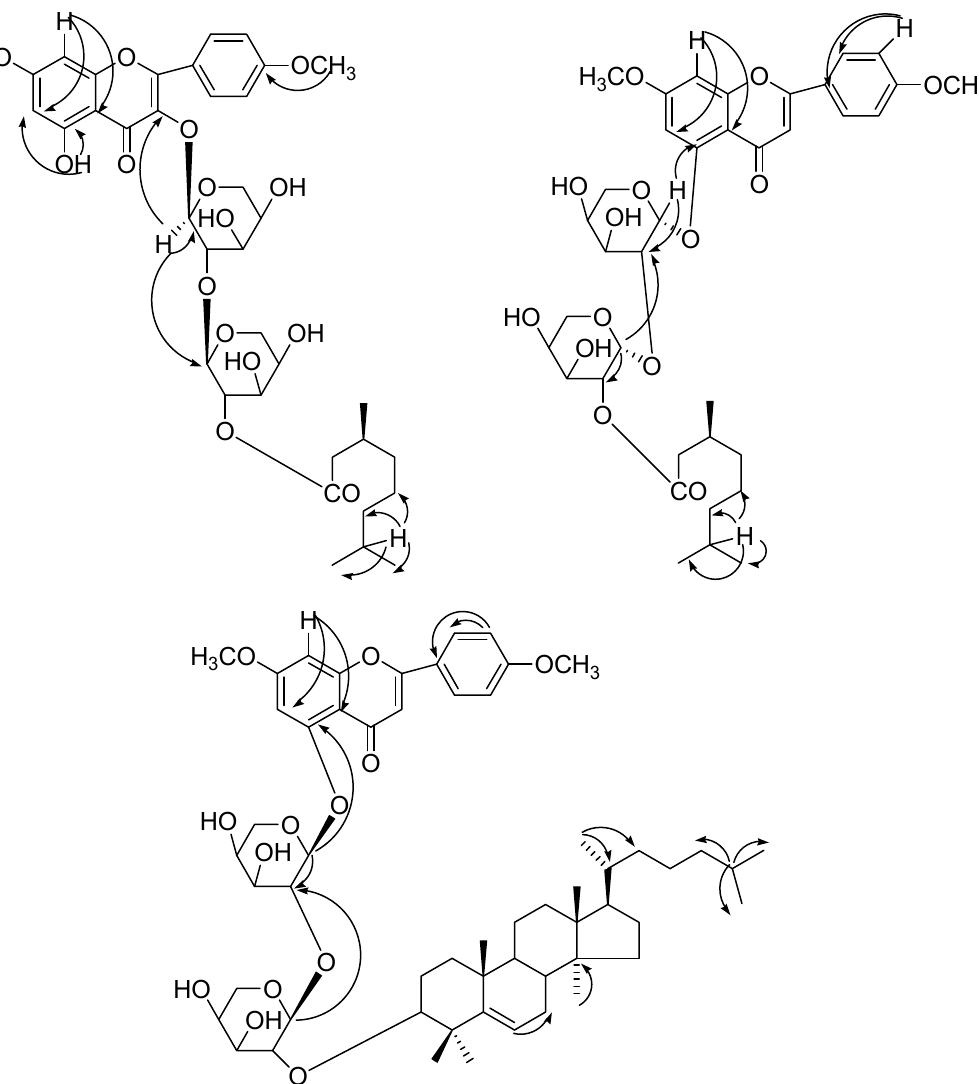
Figure 6. HMBC correlation of compounds 1 – 3 .